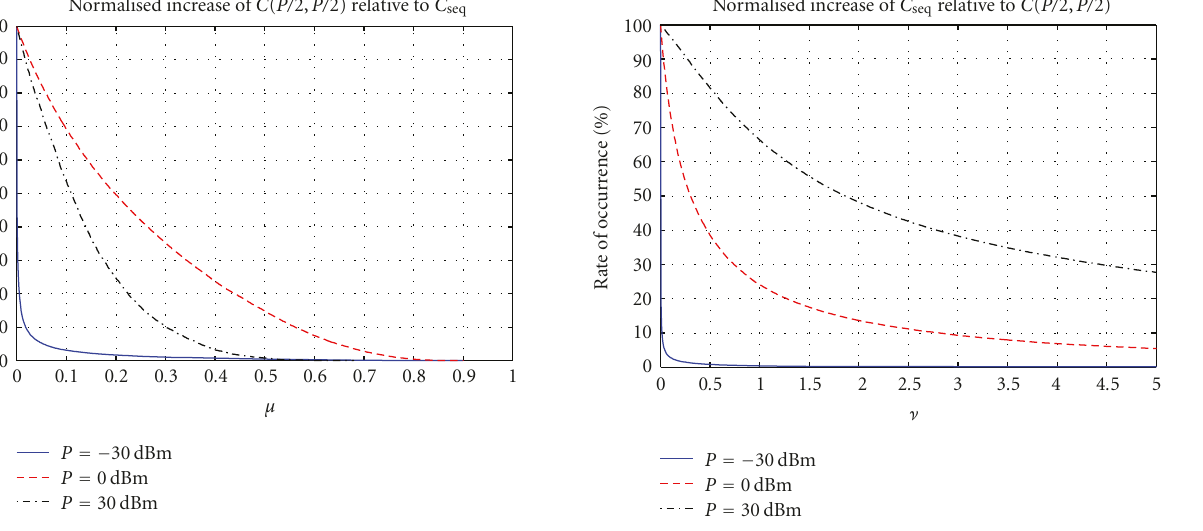
Figure 8: Normalised increase in overall spectral e ffi ciency when sequential is preferred over simultaneous transmission, ν as defined in (35). Disk radius R = 100 m.